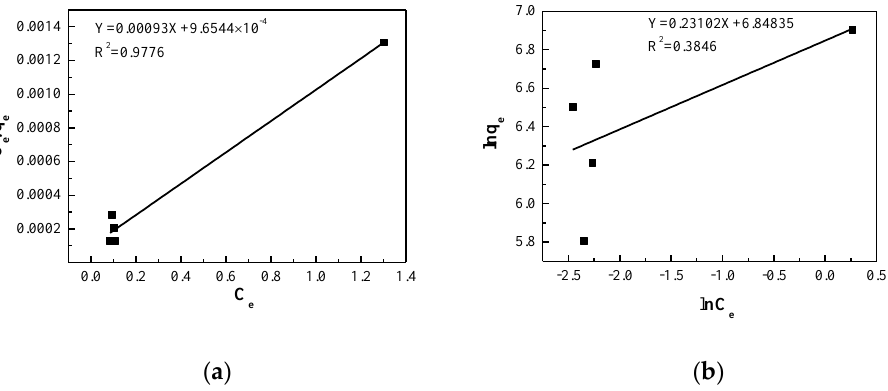
Figure 7. ( a ) Langmuir isotherm adsorption curve of GO for MB adsorption. ( b ) Fitting of the Freundlich adsorption isotherm of GO for MB adsorption. Table 3. Parameters of adsorption isotherm models for MB adsorption.